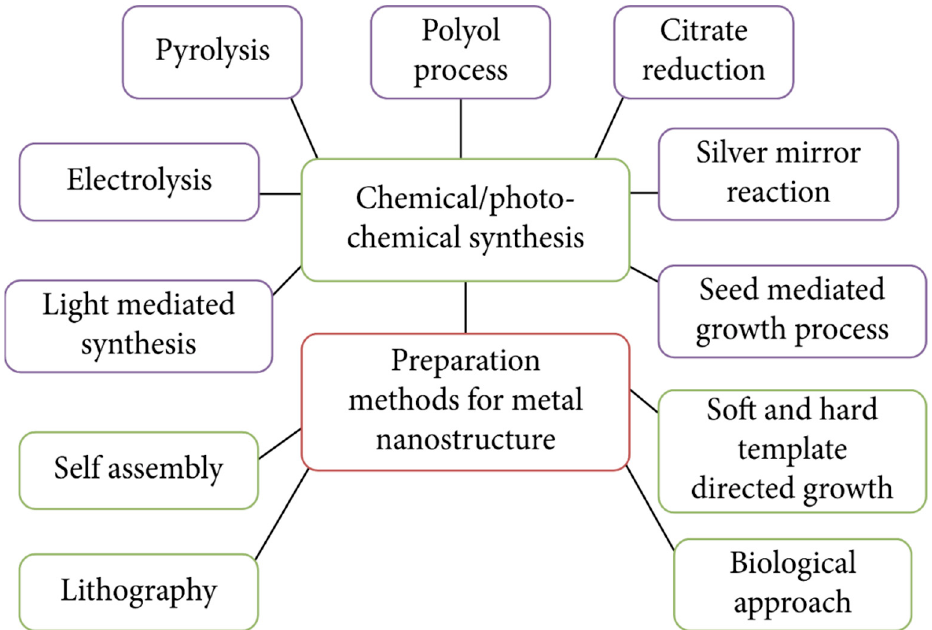
Figure 1. Different methods of synthesis of metal nanostructures. Reproduced from Ref. [26] under the Creative Commons Attribution 4.0 International (CC BY 4.0) License